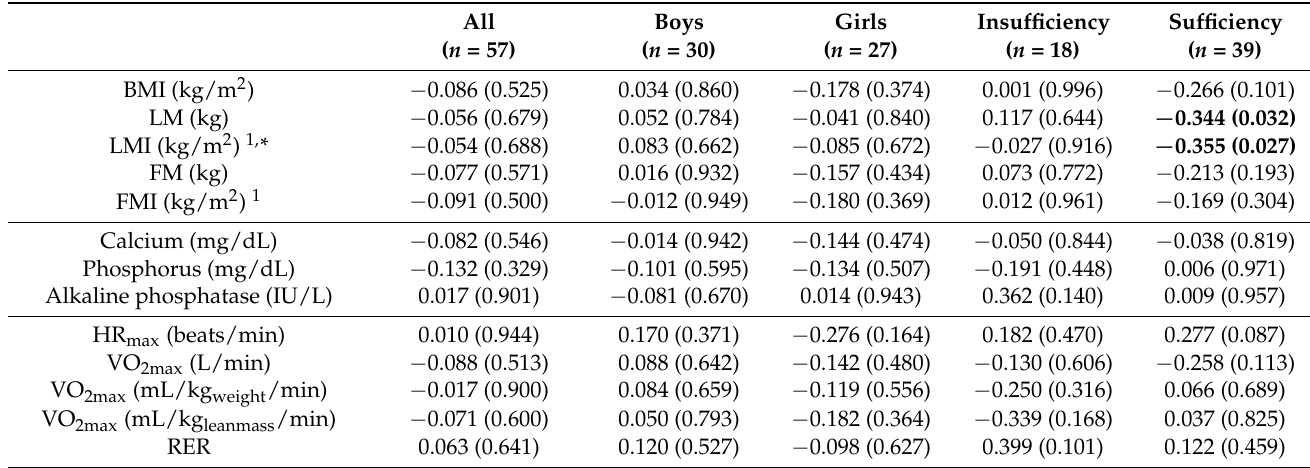
Table 2. Correlations between serum 25(OH)D and body composition or cardiorespiratory